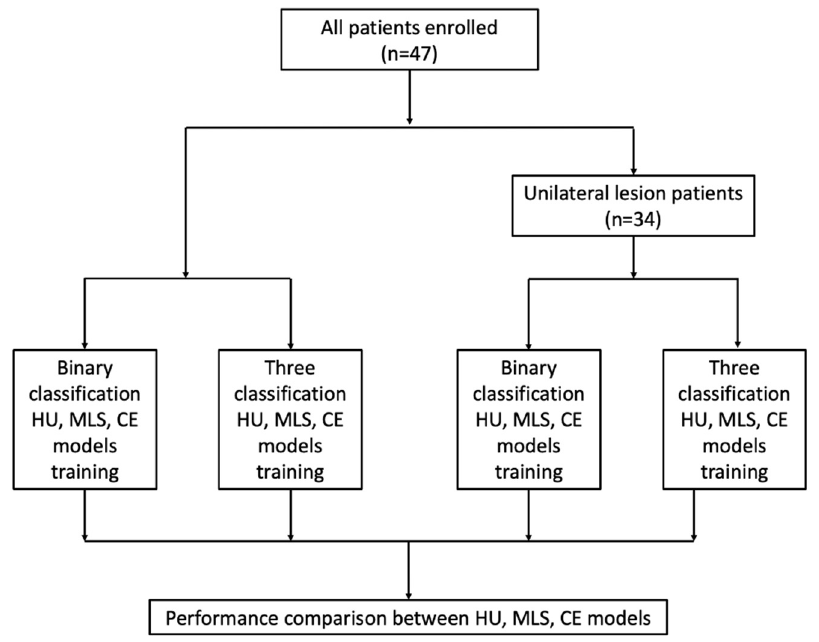
Figure 1. Model establishment and analysis process. HU, Hounsfield unit; MLS, midline shift; CE, clinical expertise.